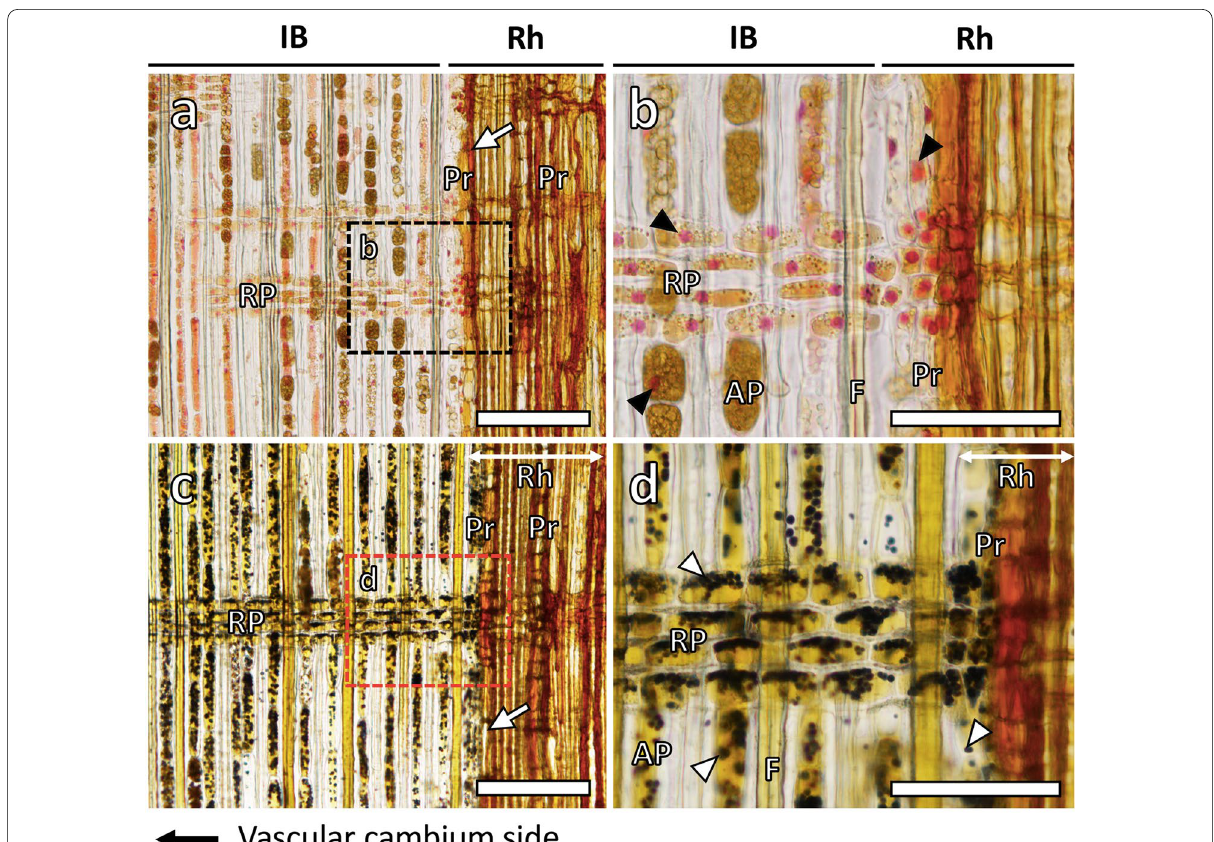
Fig. 2 Light micrographs of radial sections stained with acetocarmine ( a , b ) and iodine–potassium iodide ( c , d ), showing nuclei (black arrowheads) and starch grains (white arrowheads), just before the formation of new periderm (Stage 0) in Tree A in June, 2016. b , d Higher magnification images of the selected areas in a , c . White arrows indicate the innermost periderms. AP axial parenchyma cell, F phloem fiber, IB inner bark, Pr periderm, Rh rhytidome, RP ray parenchyma cell. The right side of each micrograph corresponds to the outer side of the tree. Scale bars